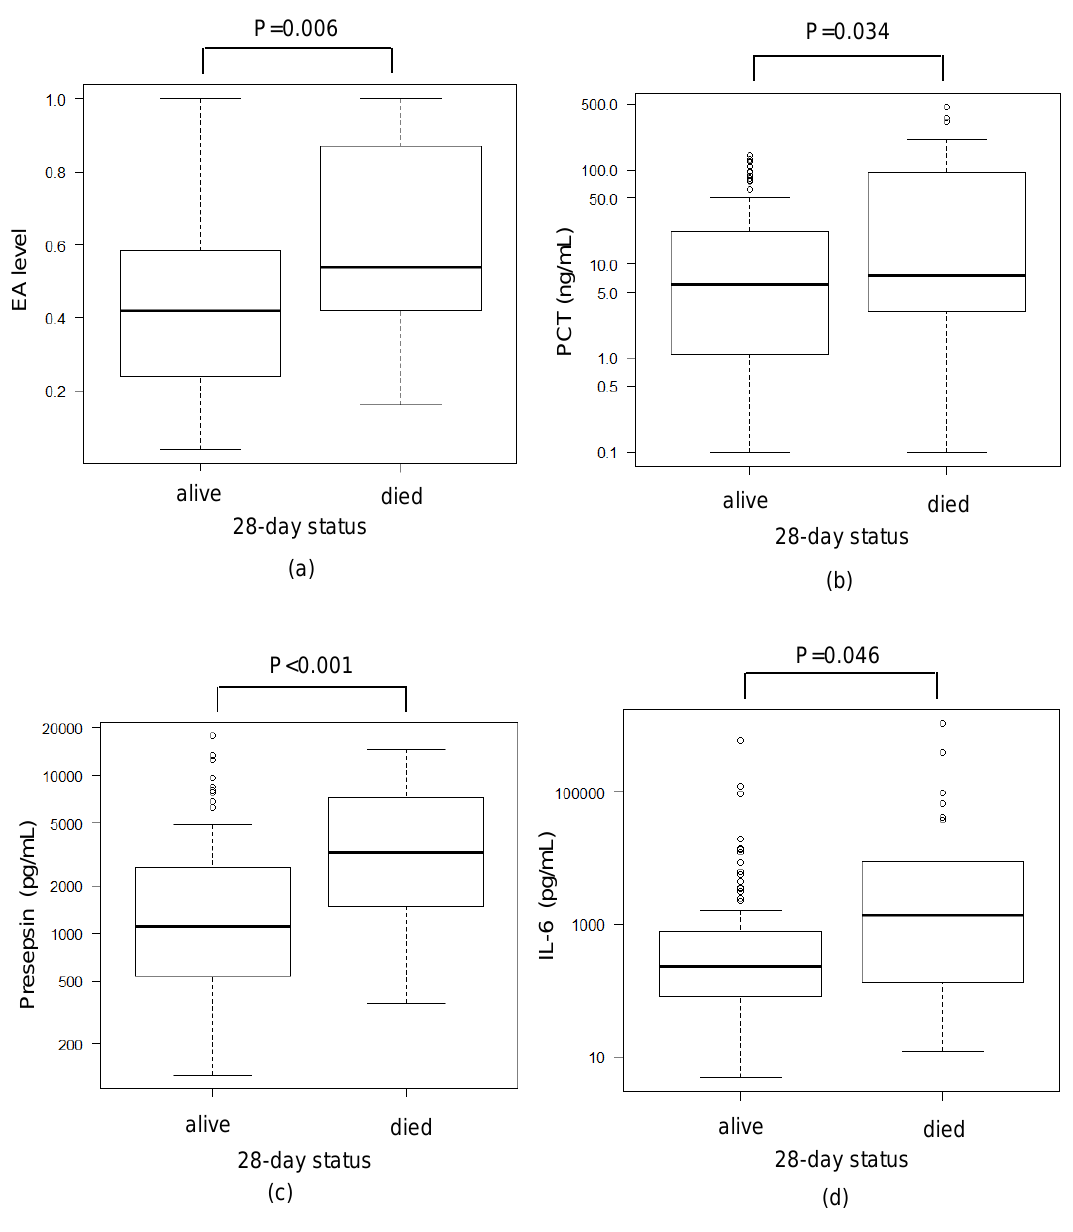
Figure 4. Comparison between mortality and various biomarkers. ( a – d ) Comparisons between the EA level ( a ), PCT level ( b ), presepsin level ( c ), and IL-6 level ( d ) in the surviving patients and non-surviving patients at 28 days. The data were analyzed by a Mann–Whitney U test. Significant di ff erences (( a ) p = 0.006 ( b ) p < 0.034, ( c ) p < 0.001, ( d ) p = 0.046) in all biomarkers were observed between